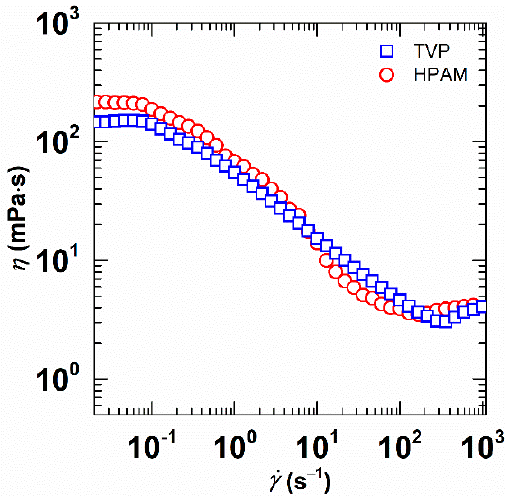
Figure 4. The apparent viscosity of 0.1% TVP and HPAM solutions with 950 mg/LTDS plotted against shear rate at 25 °C.